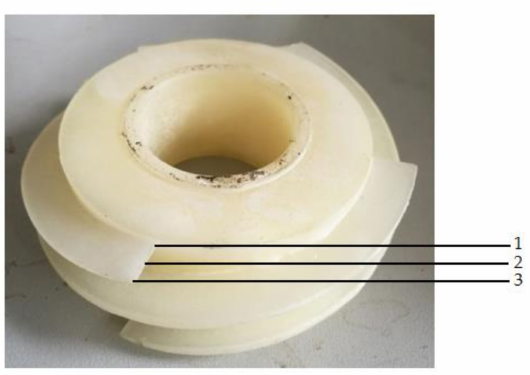
Figure 6. Physical model of the rotating impeller. 1. Hub, 2. 0.5 Span, 3.